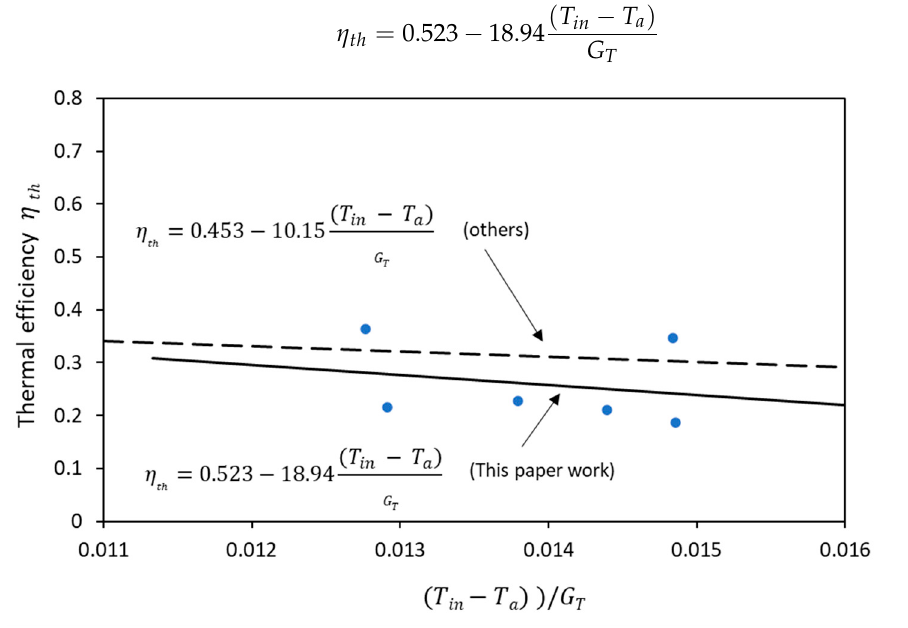
Figure 5. PVT panel efficiency equation test of this paper compared with others [22] work.